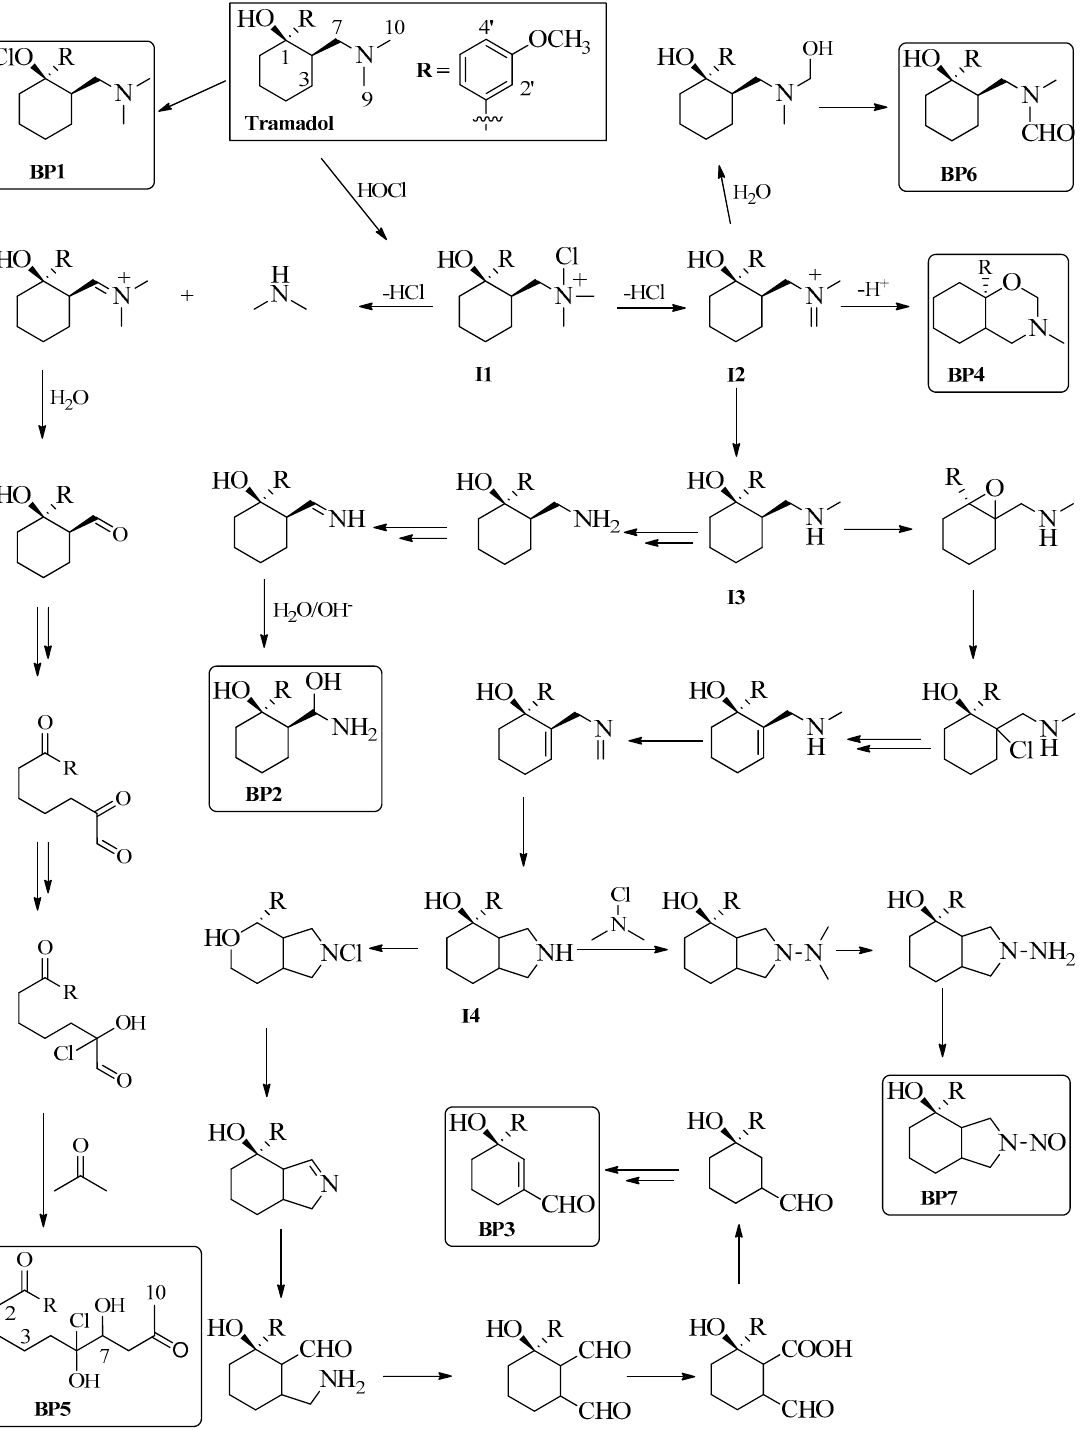
Scheme 1. Suggested pathways for the reaction of TRA with hypochlorite. Boxed structures represent isolated products.